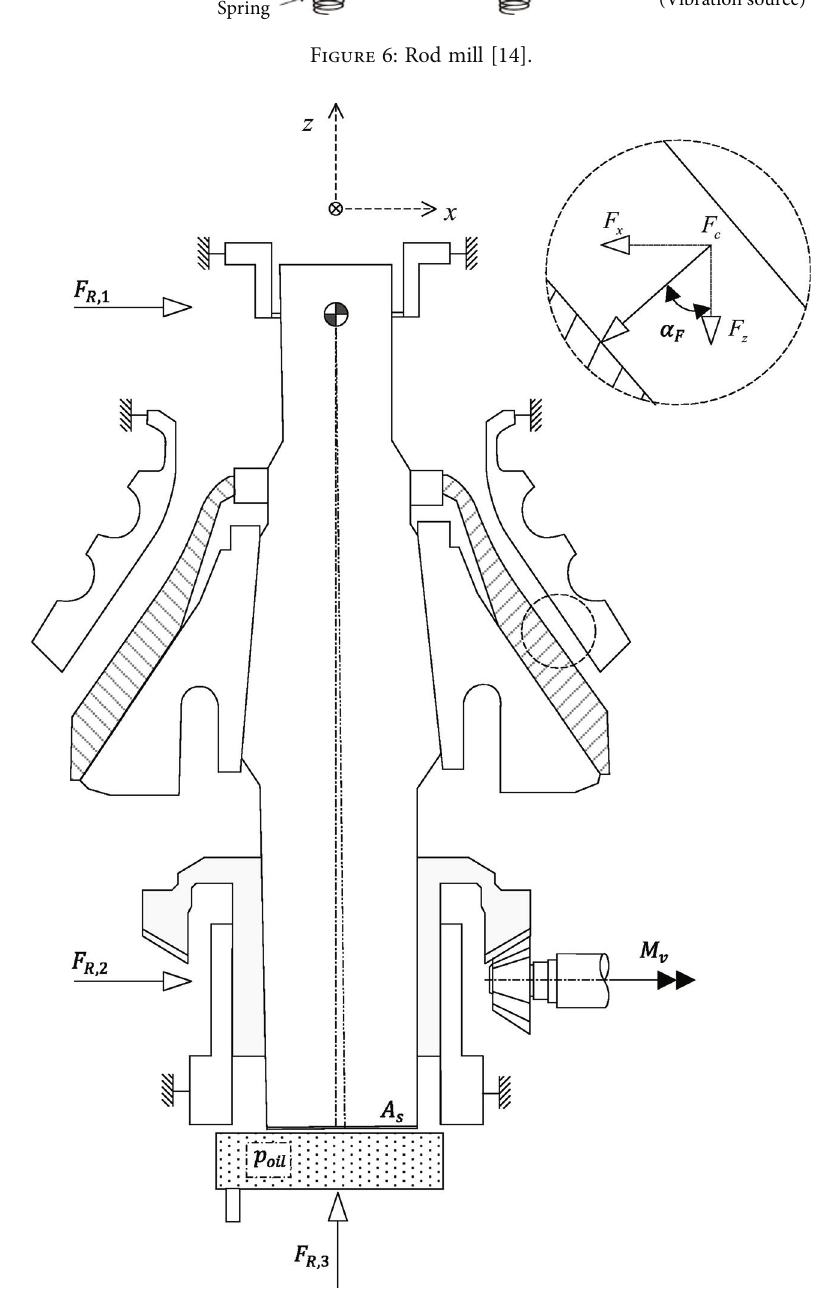
Figure 7: Schematic illustration of the cross-section of a hydrocone type cone crusher